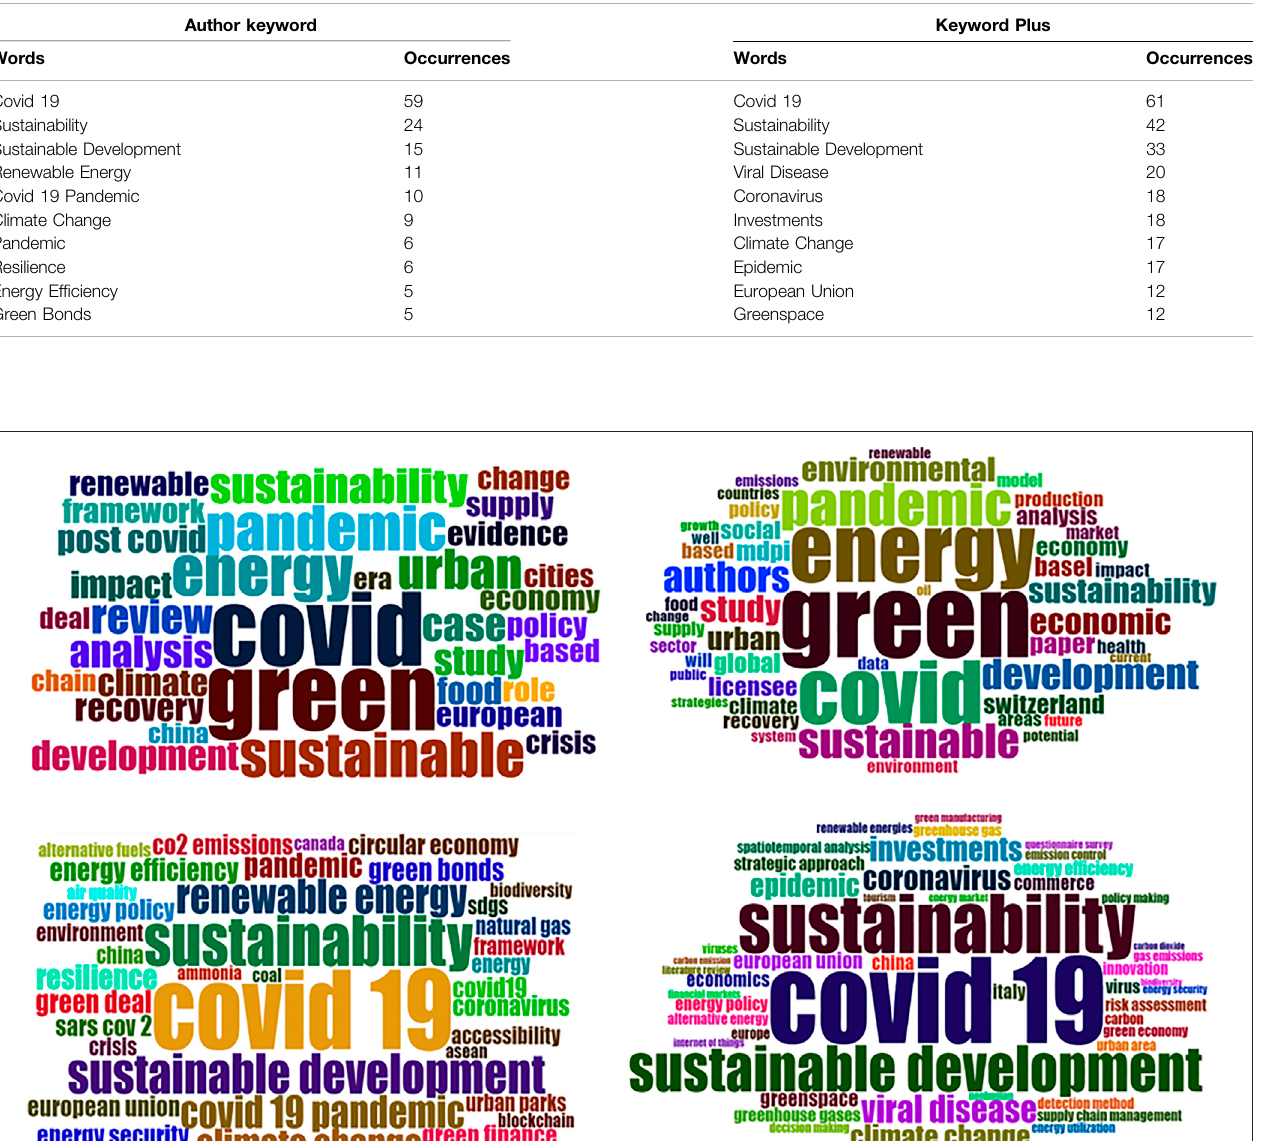
Frontiers in Energy Research |